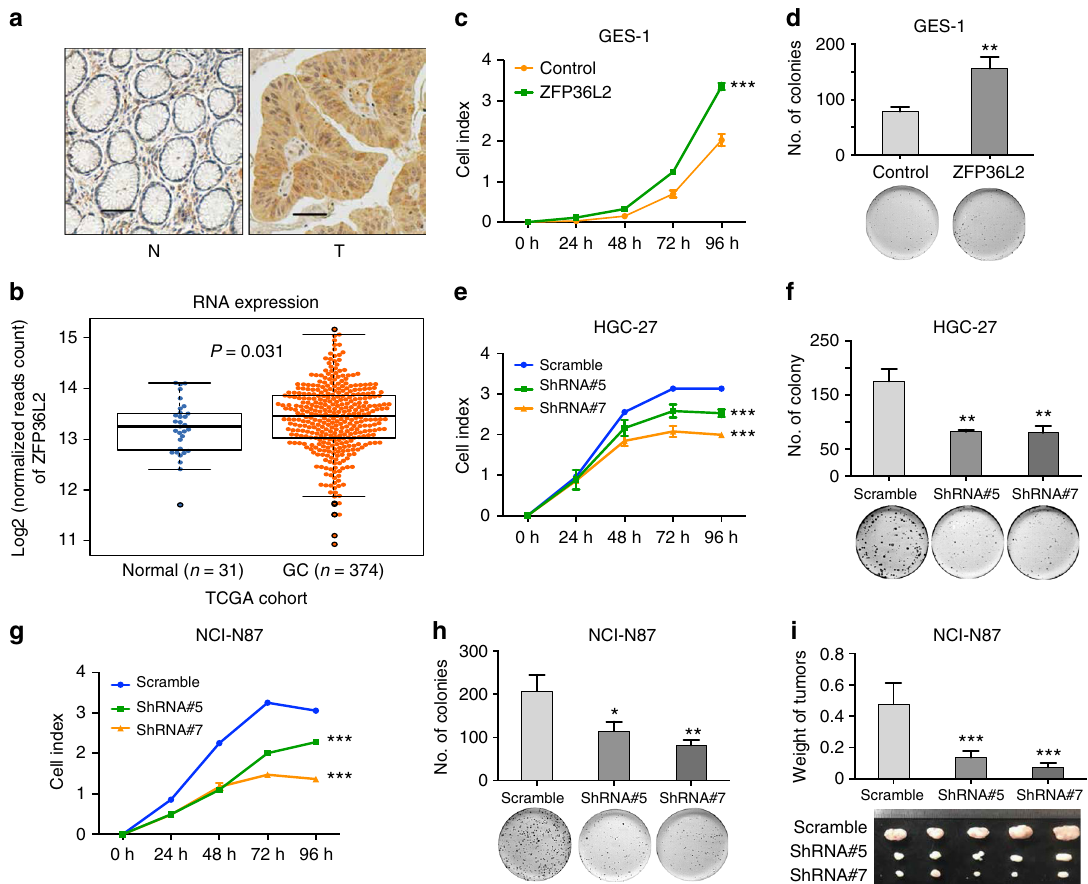
Fig. 3 Highly expressed ZFP36L2 induced by ampli fi cation promotes cell growth. a Immunohistochemistry detection of ZFP36L2 expression in GC samples with ampli fi cation. Scale bars 25 μ m. b Comparison of ZFP36L2 mRNA expression between matched nonmalignant tissues and tumor samples in the TCGA GC cohort. Center line represents the median of mRNA expression and P value was derived from Wilcoxon rank-sum test. c , d Overexpression of ZFP36L2 signi fi cantly promoted cell growth in GES-1 cells, the normal gastric epithelial cell line, as monitored by c RTCA and d colony formation assay. P values were derived from t tests. ** P ≤ 0.01; *** P ≤ 0.001. Error bars represent ± s.d. of three experiments. e , f Knock-down of ZFP36L2 signi fi cantly inhibited cell growth in HGC-27 cells, a GC cell line, as monitored by e RTCA and f colony formation assay. P values were derived from t tests. ** P ≤ 0.01; *** P ≤ 0.001. Error bars represent ± s.d. of three experiments. g , h Knock-down of ZFP36L2 signi fi cantly inhibited cell growth in NCI-N87 cells, a GC cell line, as monitored by g RTCA and h colony formation assay. P values were derived from t tests. * P ≤ 0.05; ** P ≤ 0.01; *** P ≤ 0.001. Error bars represent ± s.d. of three experiments. i The photograph of tumors obtained from nude mice injected with NCI-N87 cell transfected with shRNAs against ZFP36L2 or control.